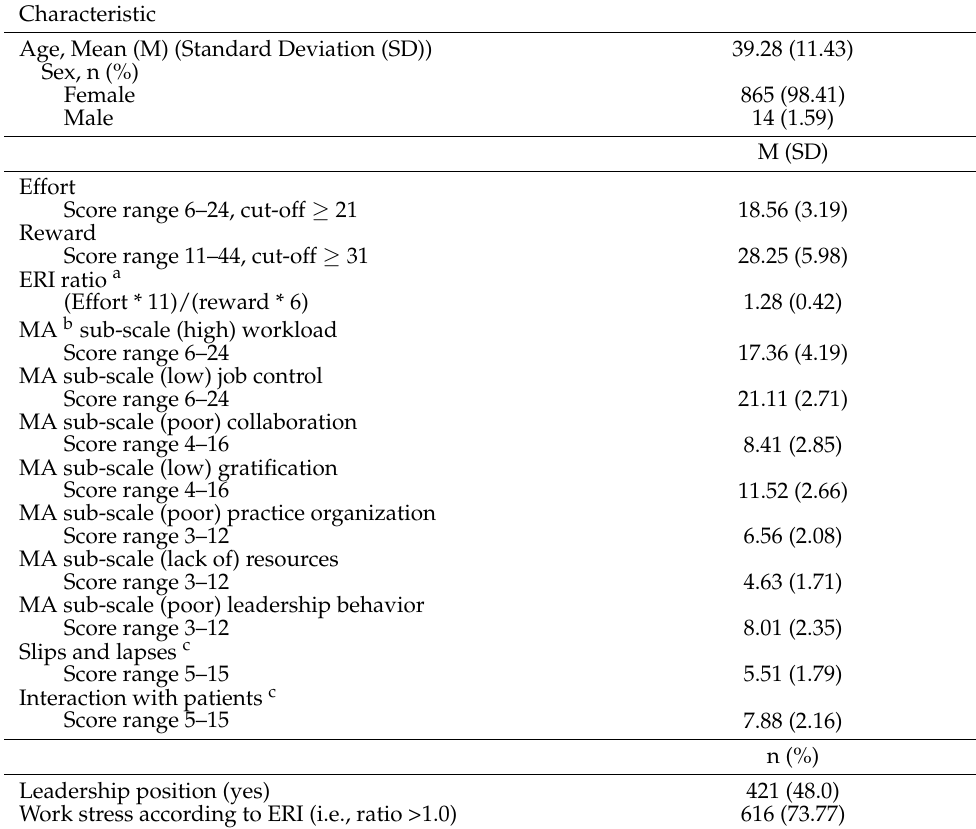
Table 2. Description of the sample (n * =